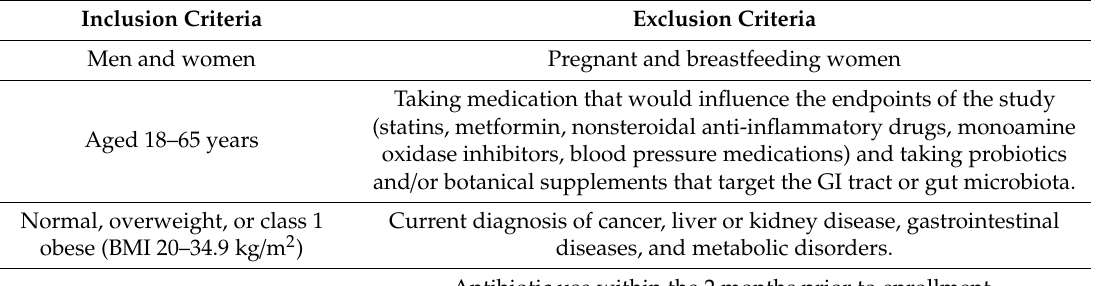
Table 1. Participant inclusion and exclusion criteria.